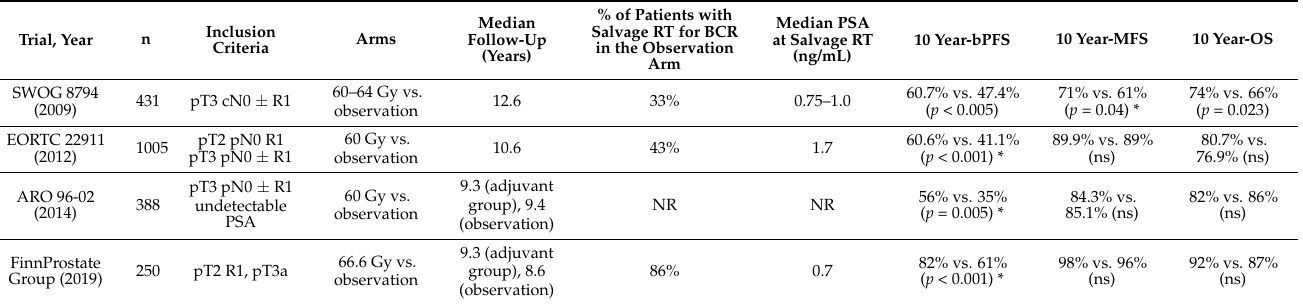
Table 1. Randomized trials assessing adjuvant RT for prostate